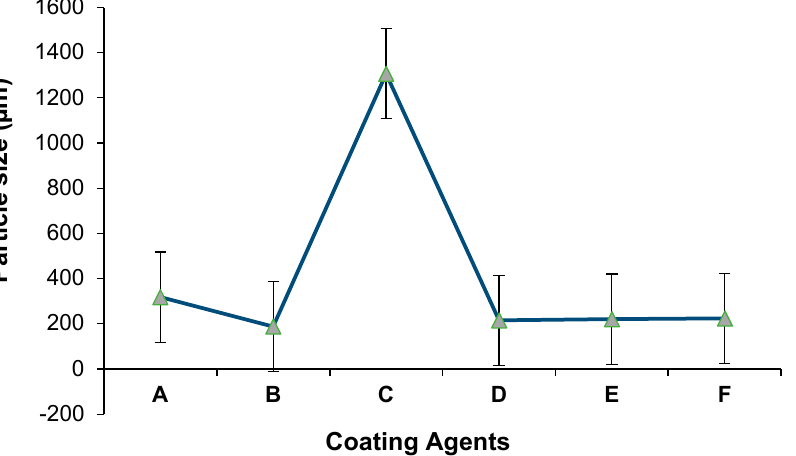
Figure 1. Particle-size distribution of the microcapsules: ( A ) alginate+xanthan gum; ( B ) algi- nate+gum acacia; ( C ) alginate+sodium caseinate; ( D ) alginate+starch; ( E ) alginate+chitosan; ( F ) algi- nate+carrageenan.